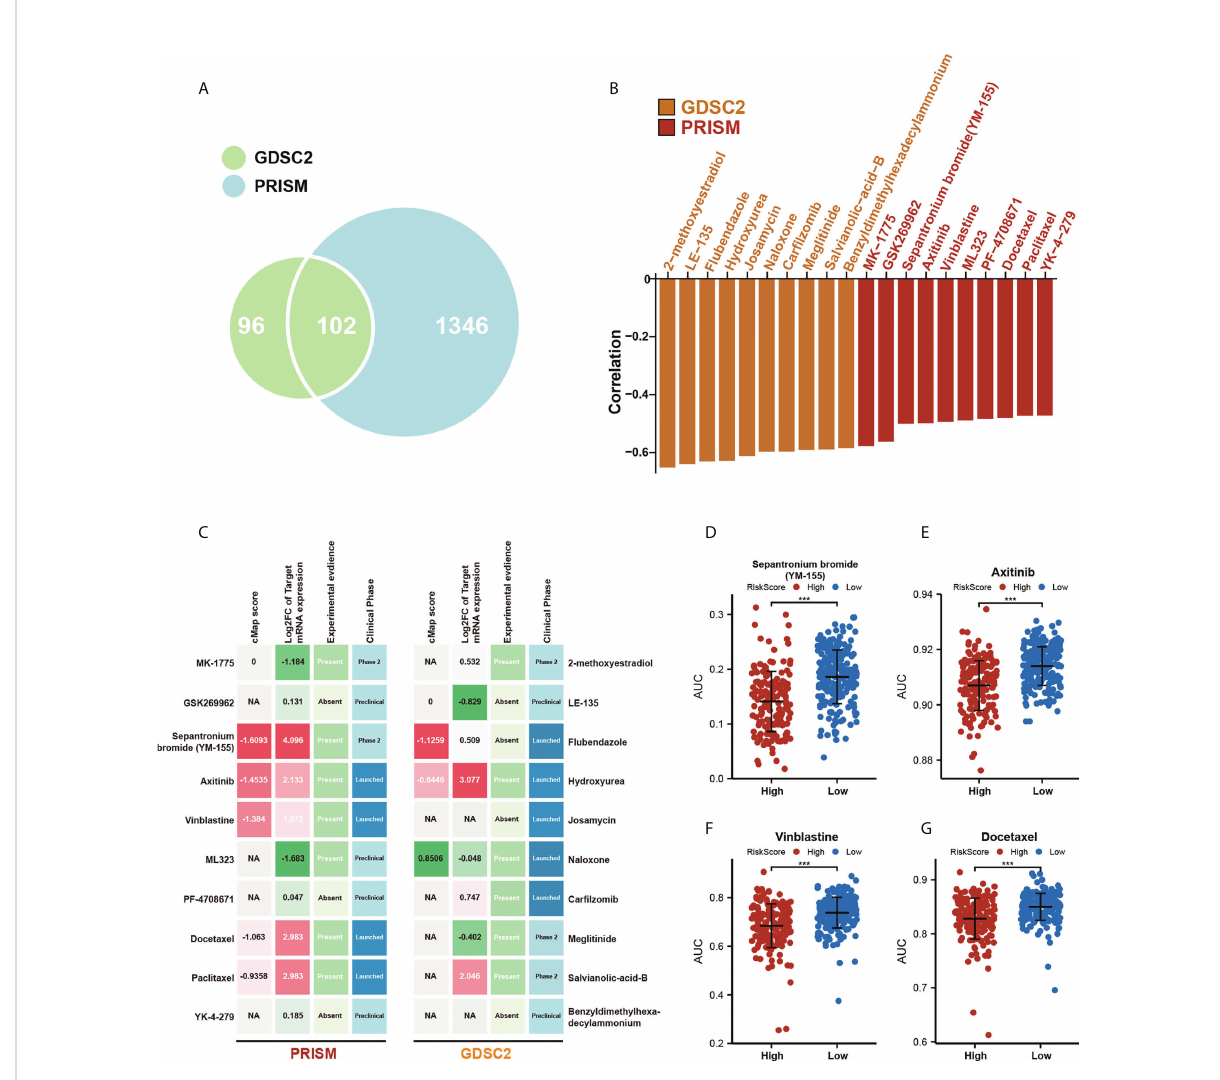
FIGURE 7 Assessing the association of potential drug sensitivity with the prognostic risk model. (A) Venn diagram for summarizing included compounds from GDSC and PRISM datasets. (B) Top 10 associated compounds with m 5 C score in two drug databases (GDSC2, PRISM). (C) Identi fi cation of the most promising therapeutic agents for high m5C score patients according to the evidence from multiple sources, 10 GDSC-derived agents and 10 PRISM-derived agents were shown on the left and right of the diagram, respectively. (D-G) Differential drug response AUC analysis of 4 selected compounds (Wilcoxon test, *** p <